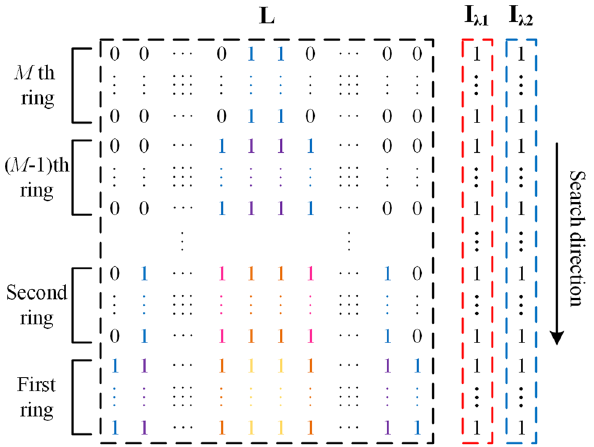
Figure 2. Matrixes L , I (cid:31) 1 and I (cid:31) 2 were discretized by progressive search method. L is a matrix in which the “1” refers to nonzero value and the “0” refers to zero value, and “1” painted by same color represent same value of soot volume fraction and temperature in this location.